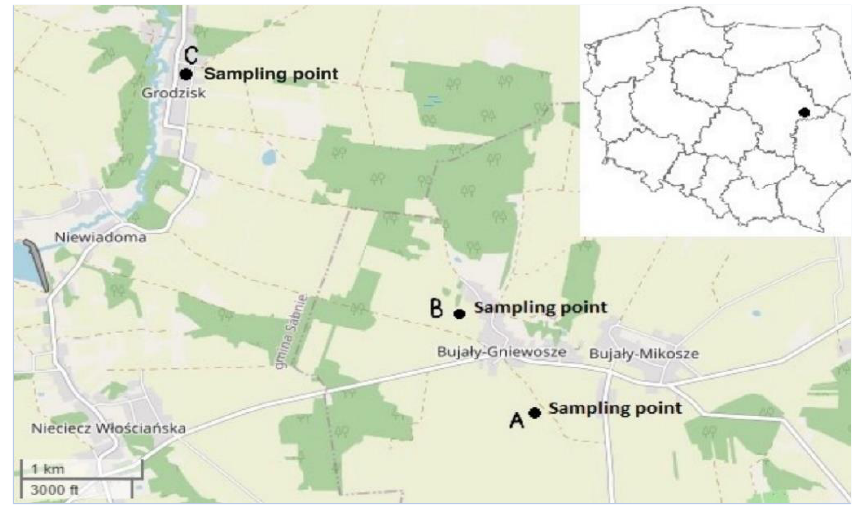
Figure 1. Locations of the sampling points (https://www.openstreetmap.org/#map=12/52.1036/22.1357 (accessed on 4 March 2022)) [14]. From each moisture zone, 85 plant samples representing each species were collected.